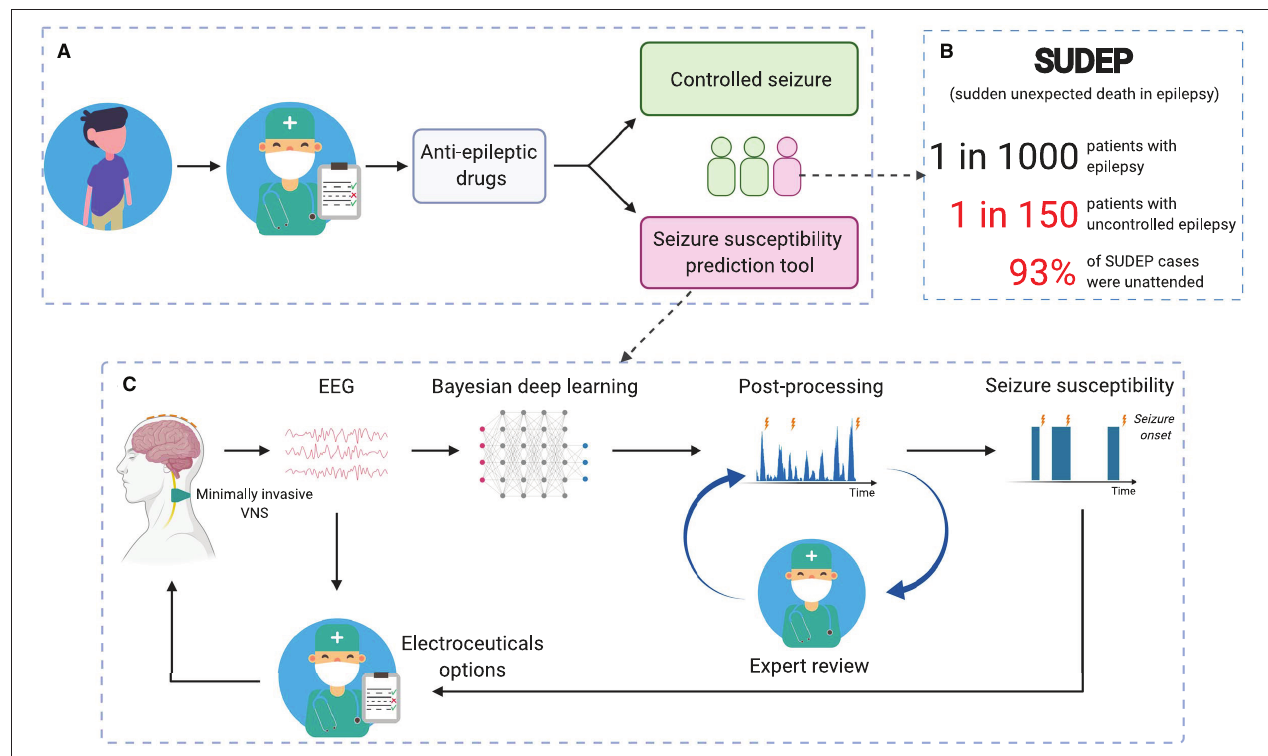
FIGURE 1 | Reducing SUDEP (sudden unexpected death in epilepsy) risk with seizure forecasting based on reliable long-term EEG monitoring. (A) Simplified pathway for patients with epilepsy. (B) The fact that most SUDEP cases were unattended (20, 21) emerges the need for reliable 24/7 and long-term EEG monitoring. (C) Seizure susceptibility prediction tool to suggest alternative treatments [e.g., vagus nerve stimulation (VNS)] for patients with uncontrolled